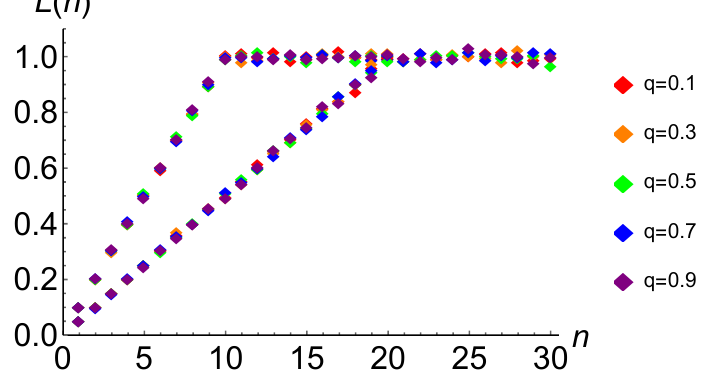
Figure 4: The numerically computed connected unfolded SFF’s for N “ 10 and N “ 20, which can be distinguished by the fact that they arrive at a plateau at n “ 10 and n “ 20, respectively. Note that we plot only the connected SFF here, as opposed to figures 1 and 2, to simplify comparison with Wigner-Dyson universality. It is clear that Wigner-Dyson universality is recovered to high precision for both N “ 10 and N “ 20 and all q considered